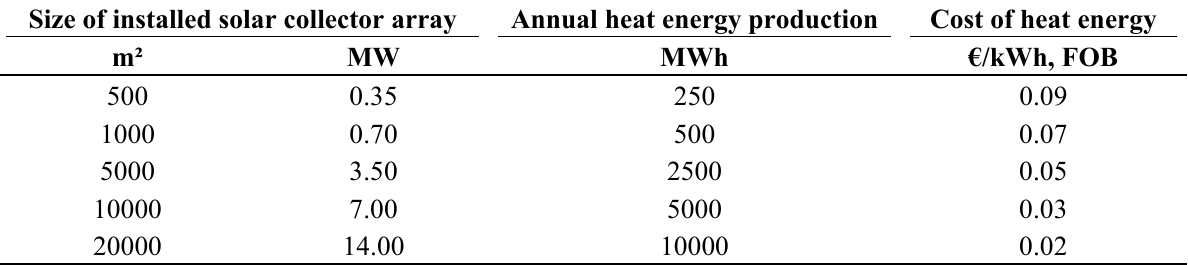
Table 1. Solar heat cost according to the system size assuming that 1 m 2 is rated at 700 W and produce 500 kWh/yr heat energy at suitable temperatures for DHW systems